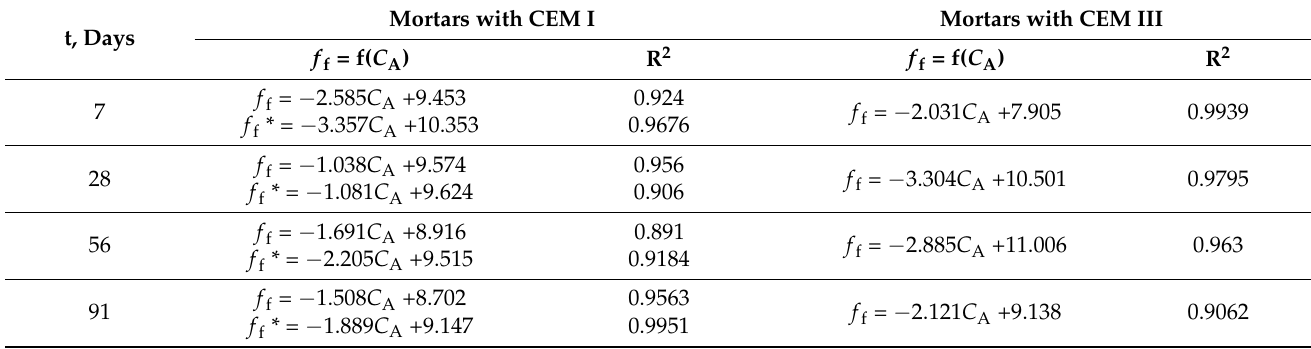
Table 6. Dependence of flexural strength on the amount of admixture containing aluminum powder and type of cement. Mortars with CEM I Mortars with CEM t, Days